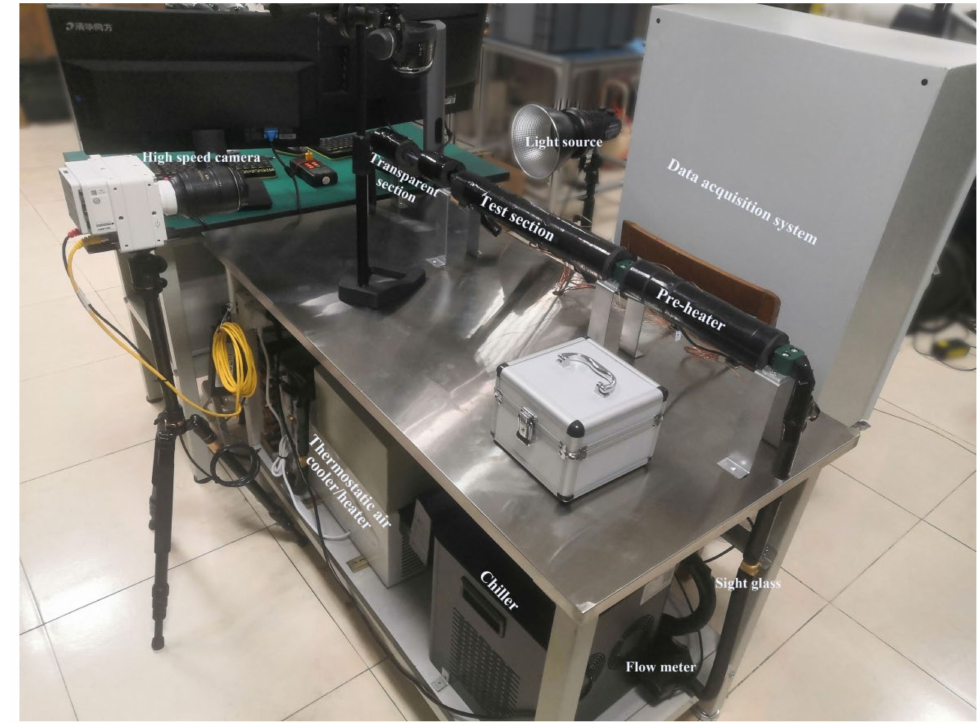
Figure 3. Experimental system: